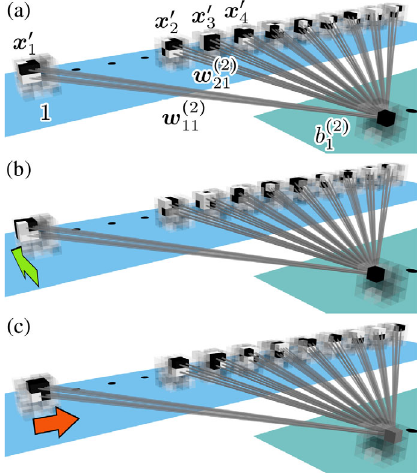
FIG. 5. Construction of a volumetric feature map. To produce the highlighted neuron in the volumetric feature map, from the 2 Þ 2 × 2 × 2 local input, a shared filter w ð l 1 is convolved with a receptive cube x 0 l across all the inputs in the imaginary time slices, 2 Þ adding a bias offset b ð 1 , before being activated using ReLU. Sliding the 2 × 2 × 2 cube in each of the spatial dimension while repeating the convolutional procedure completes a volumetric feature map. The spatial size of the volumetric feature map can be preserved by using zero